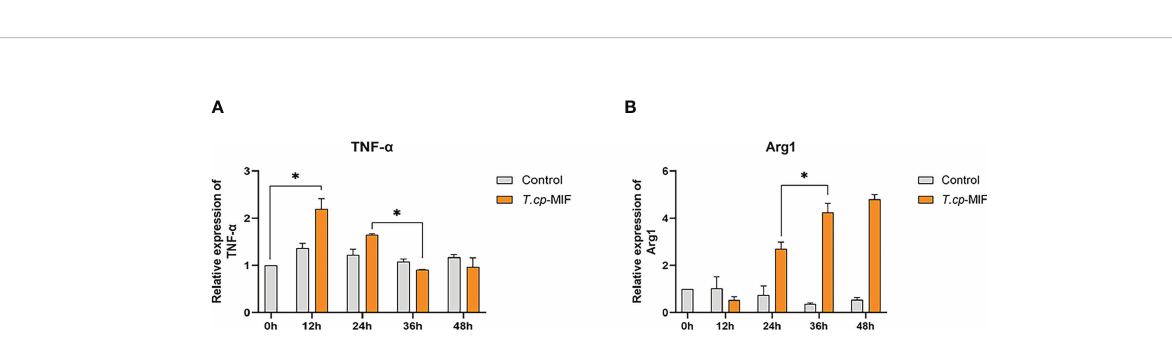
FIGURE 5 Effects of T.cp -MIF on TNF- a and Arg1 at different time. TNF- a and Arg-1 mRNA levels were analyzed by RT-qPCR and normalized against GADPH mRNA. (A) the expression of TNF- a . (B) the expression of Arg1. * indicated P<0.05. Results are expressed as the mean of three times of independent experiments ( x ̄ ±SD,